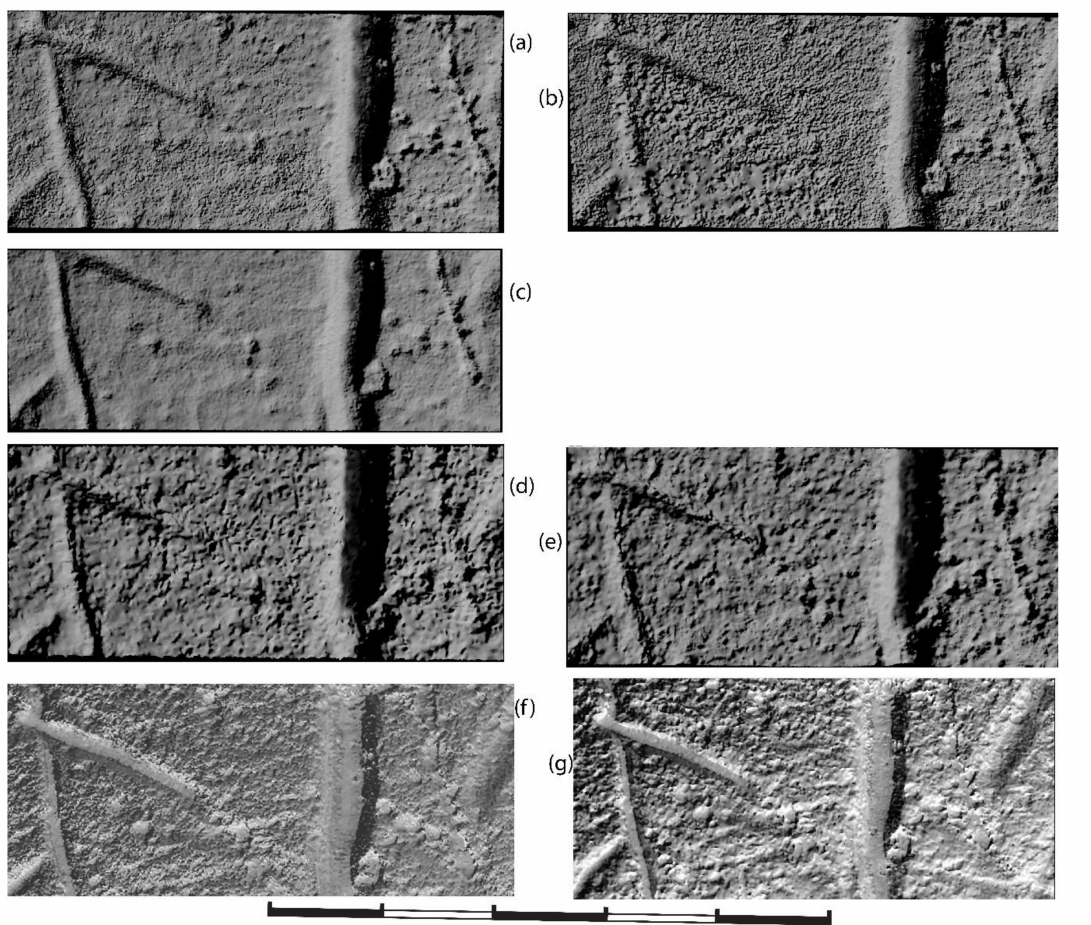
Figure 6. Detail from Surface B. ( a ) IBM-MS; ( b ) IBM-RC; ( c ) Combo 1-RC; ( d ) Combo 2-MS; ( e ) Combo 2-RC; ( f ) H-RTI; and ( g ) RL-RTI. The RTI models are the most detailed, while the Combo 1 model